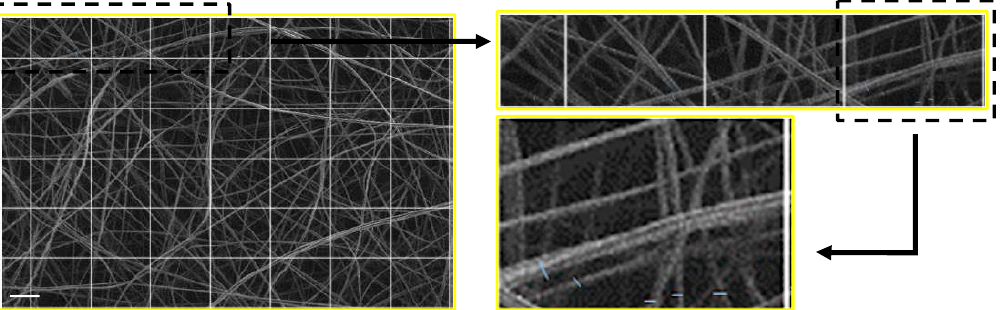
Figure 3. Sampling of the fibers to determine the average diameter for sample PANPCL_02 (PAN 50%) at a suitable magnification of 5000×. A grid is superimposed on the SEM micrograph and diameters are measured once for each fiber that intersects the grid, as indicated by blue lines. Scale bar = 4 µ